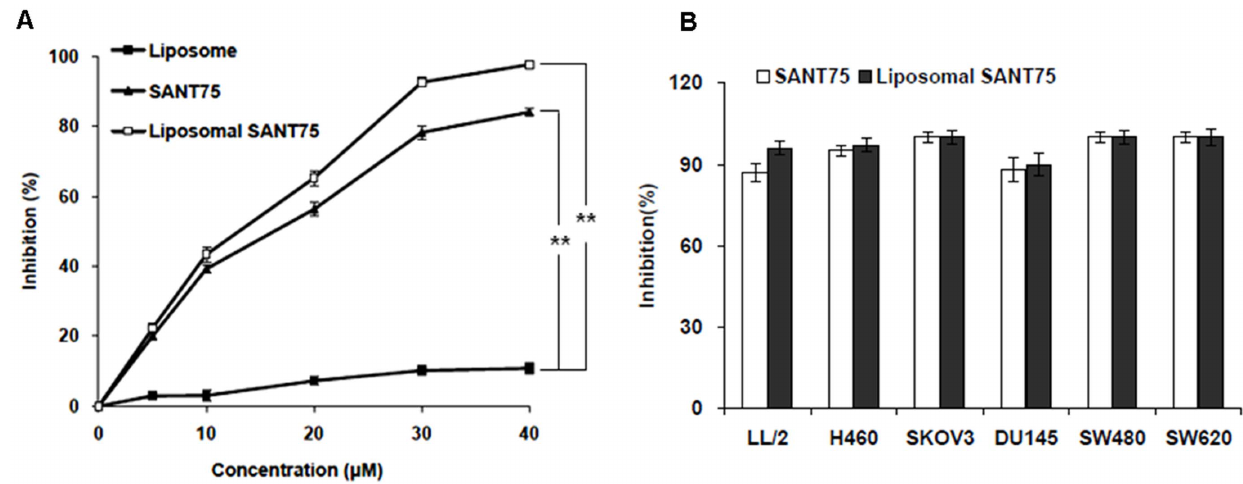
Figure 4. Inhibition of tumor cell proliferation treated with liposomal SANT75, free SANT75 or free liposome. (A) Concentration- dependent inhibition of proliferation of LL/2 cells by different formulations. **, P , 0.01, liposome group versus free SANT75 or liposomal SANT75 group. (B) The inhibition rate of LL/2, H460, Skov3, DU145, SW480, and SW620 tumor cell lines by liposomal SANT75 or free SANT75 at equivalent dose of 40 m M.